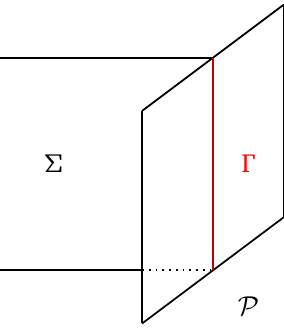
⊂ S , ending on the co- P 6 d . This P